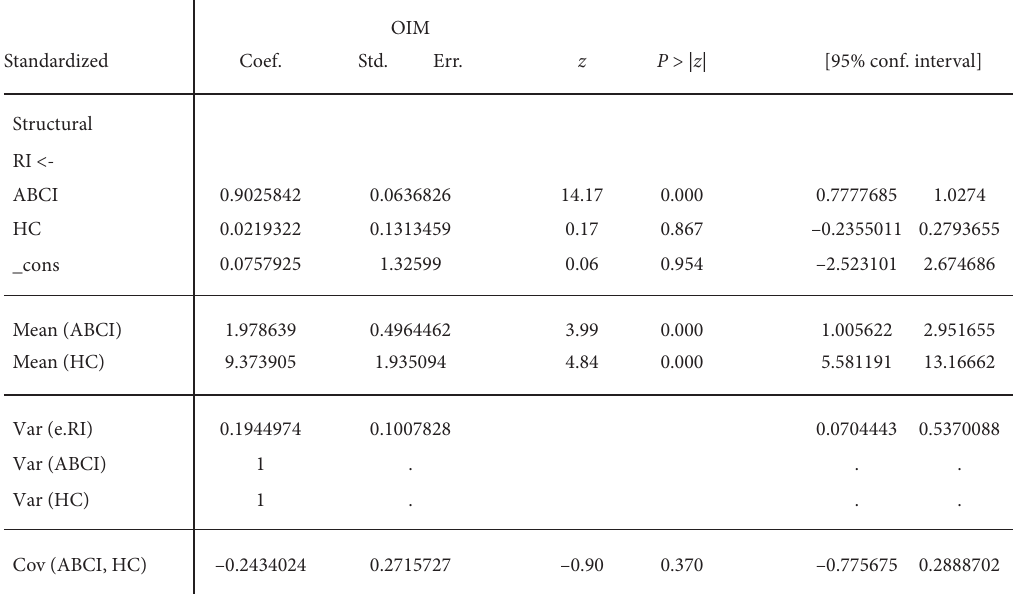
Figure 9: Tabular form of the magnitude of the effectiveness of ABCI and HC over RI as shown in Figure 6.